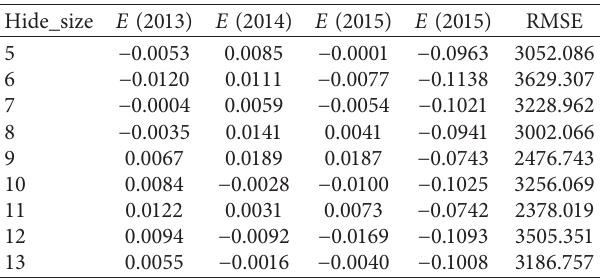
Table 5: Hyperparameters value of the LSTM layer.